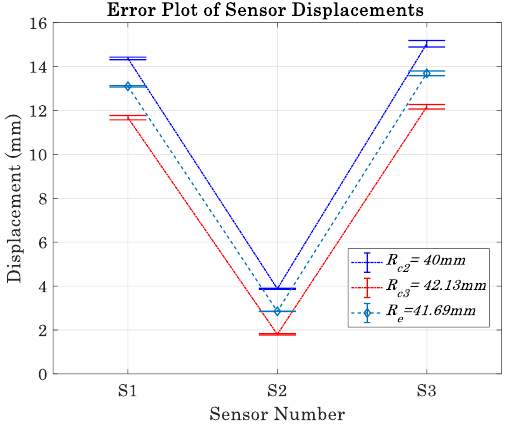
Figure 13. Displacements measurement obtained for the calibration master and an inspected part. Each displacement was measured three